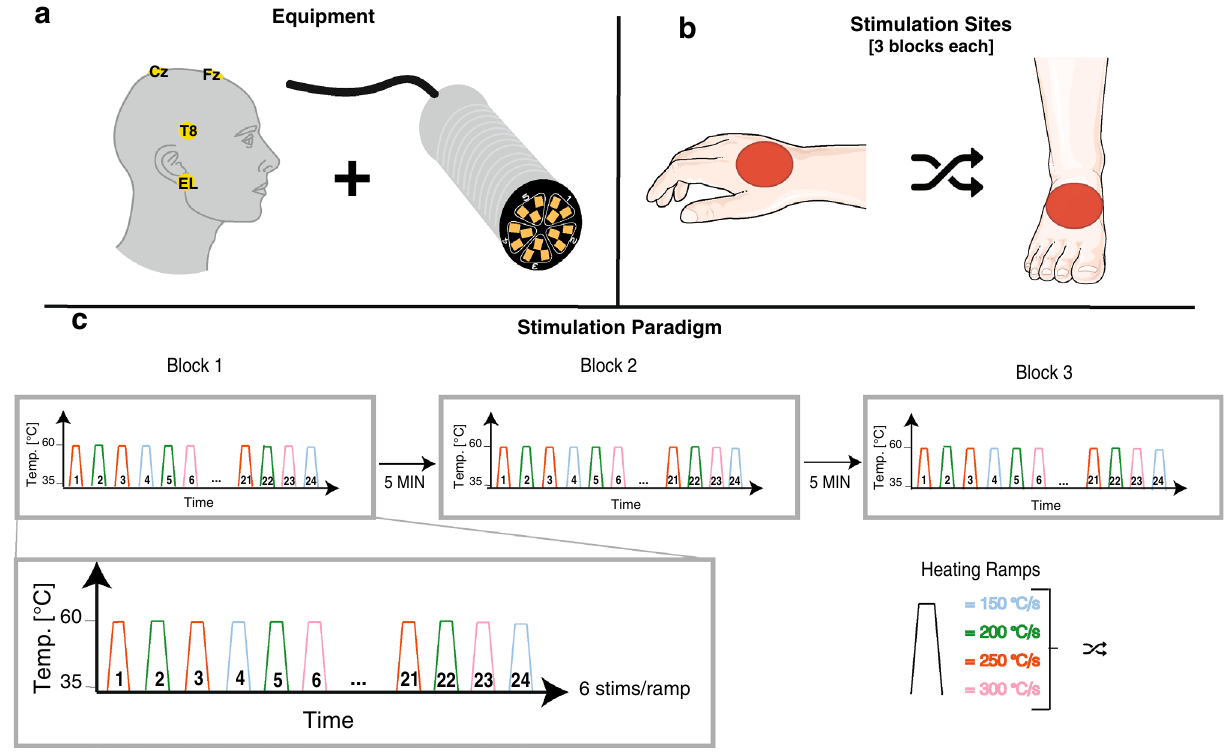
Figure 1. Study design. ( a ) Used equipment during the experiment. Illustrated are the placement of the single cup electrodes for the EEG measurement (left) and the thermode with the 15 micro-Peltier elements (right). ( b ) Illustrated are the two stimulation sites (dorsum of the dominant hand and foot) that were tested in a randomized order. ( c ) The stimulation paradigm consisted of three blocks of consecutive contact heat stimulations. One block consisted of six stimulations of each heating ramp that were applied in a randomized order. The stimulation blocks were separated by a break of 5